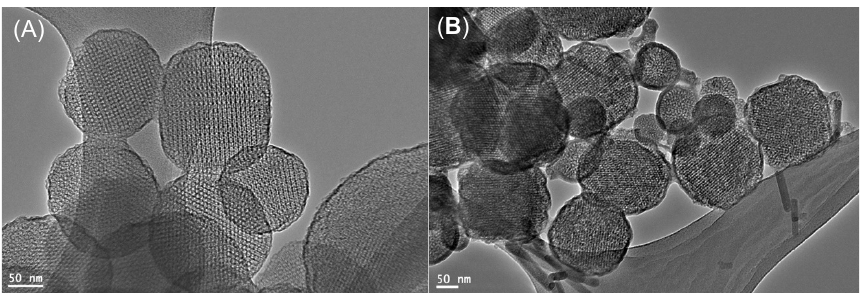
Figure 3. The morphology and mesostructure of nanoparticles: ( A ) TEM image of MSNs, and ( B ) TEM image of PDEAEMA–MSNs.